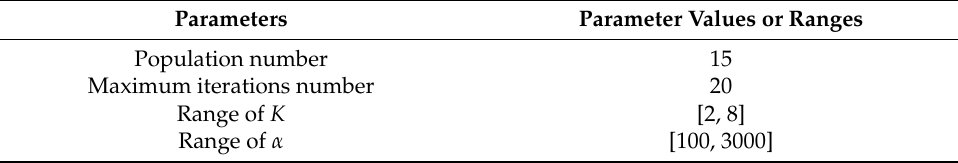
Table 3. Parameter configuration of